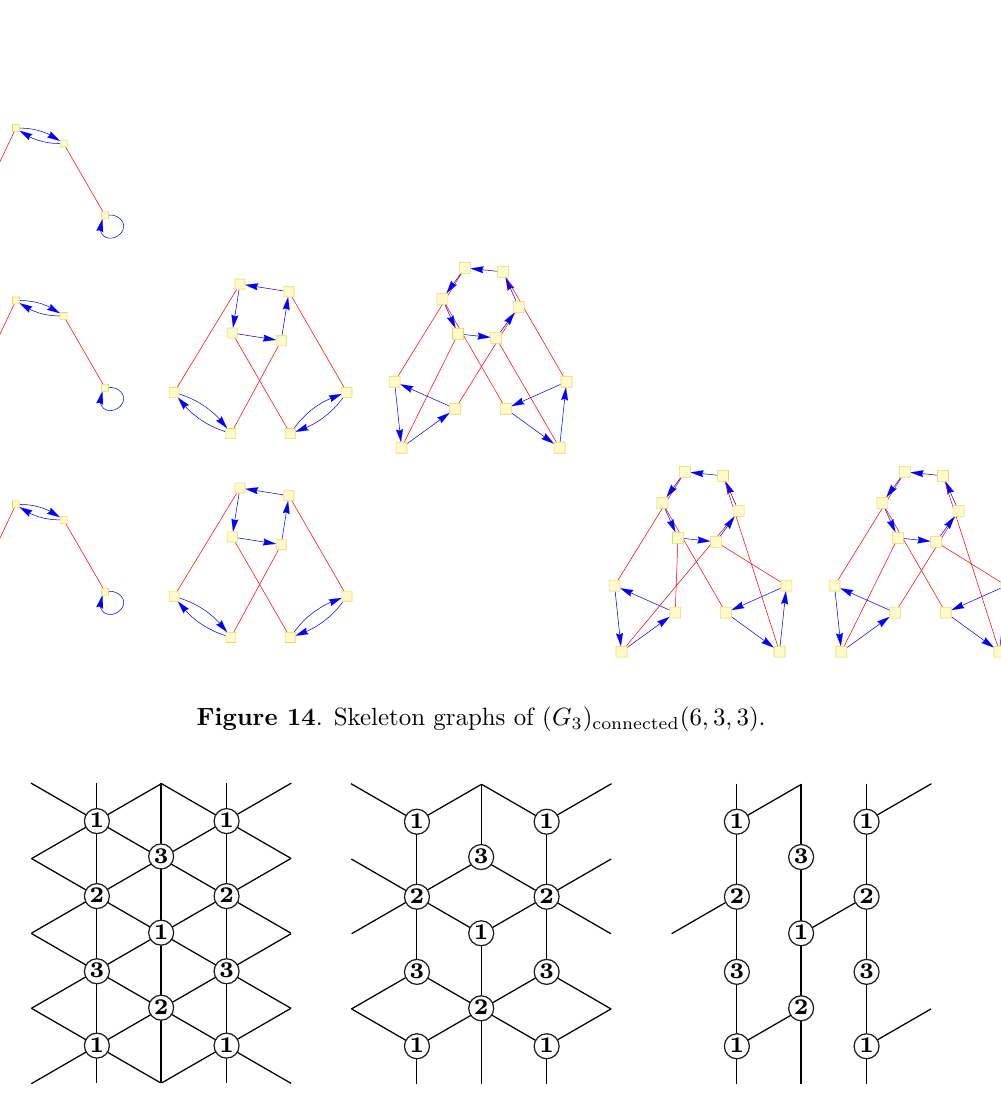
, representing [ (cid:23) ] = [3 6 ] ; [4 3 ] ; [8 1 ]. The diagram 1 ; 3